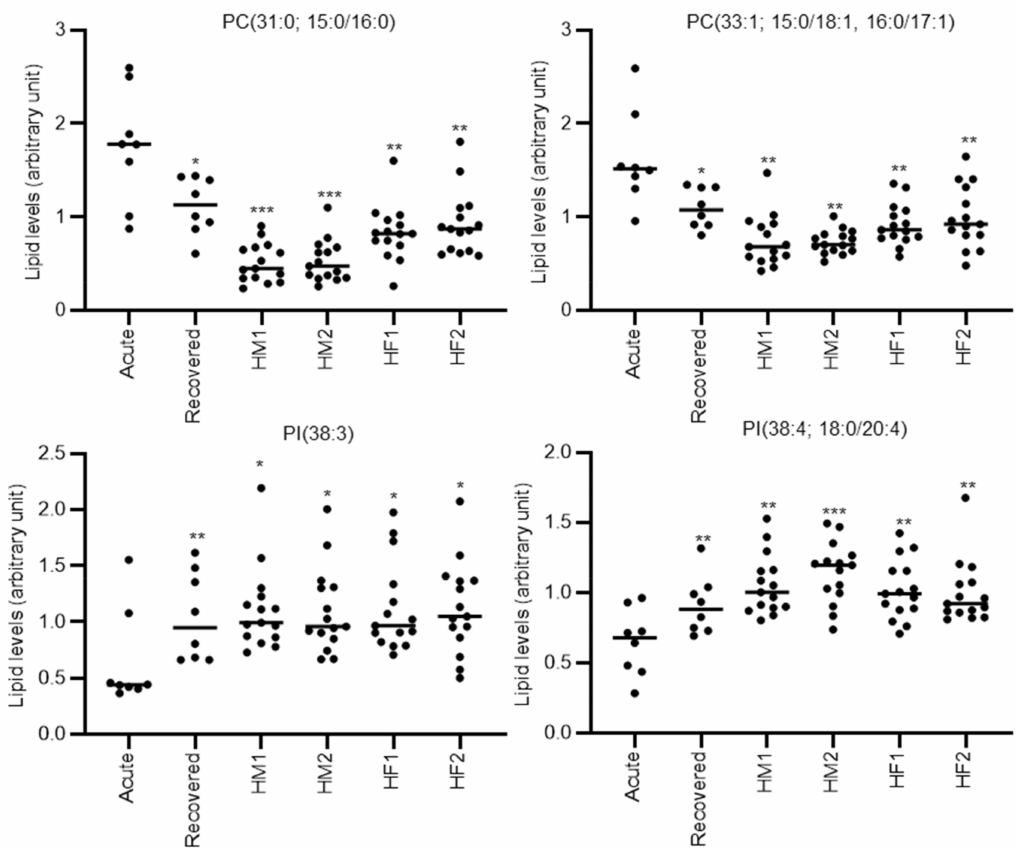
Figure 3. Representative individual plots of lipids levels discriminating the acute phase of cholestatic-type DILI from the recovery phase and the four healthy volunteer groups. Each dot represents an individual sample. Statistical significance is indicated as follows: * p < 0.05, ** p < 0.01, *** p < 0.001. Acute; acute phase DILI patients, Recovered; recovery phase DILI patients, HM1; healthy male subject group 1 (approximately 45 years old), HM2; healthy male subject group 2 (approximately 60 years old), HF1; healthy female subject group 1 (approximately 45 years old), HF2; healthy female subject group 2 (approximately 60 years